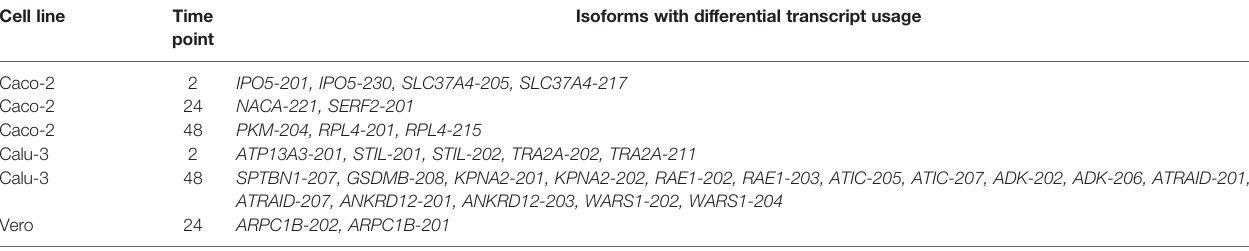
TABLE 5 | List of isoforms with signi fi cant differential usage in Caco-2, Calu-3 and Vero. Cell line